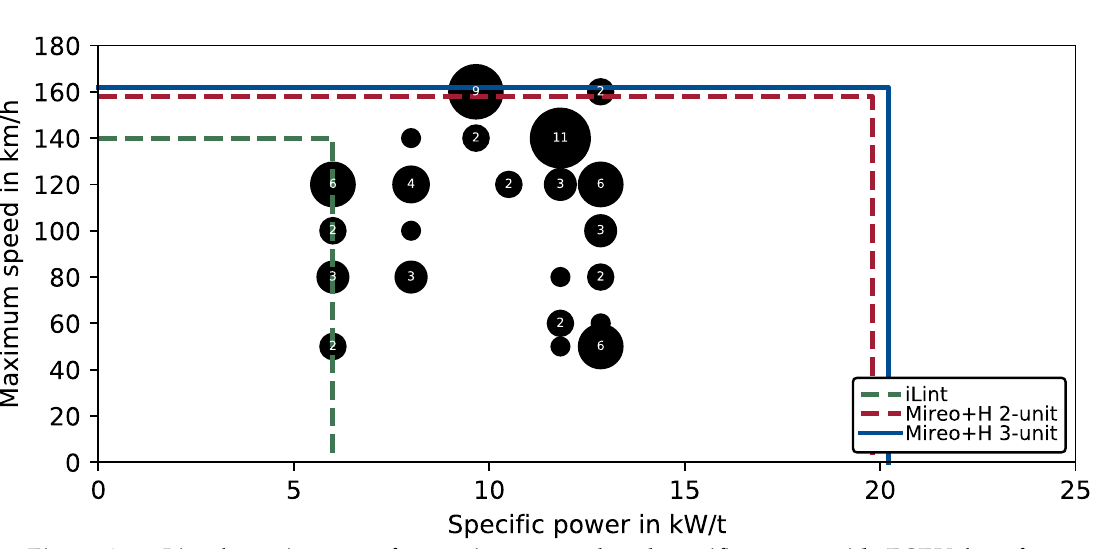
Figure 4. Lines’ requirements for maximum speed and specific power with FCEVs’ performance